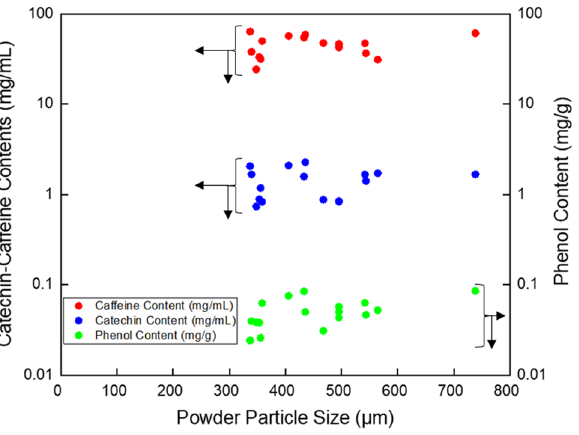
Figure 1. Distribution of major chemical contents of bancha green tea regarding the powder particle